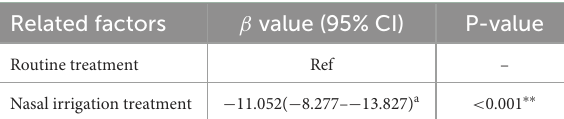
TABLE 3 Multiple linear regression analysis for nucleic acid negative conversion